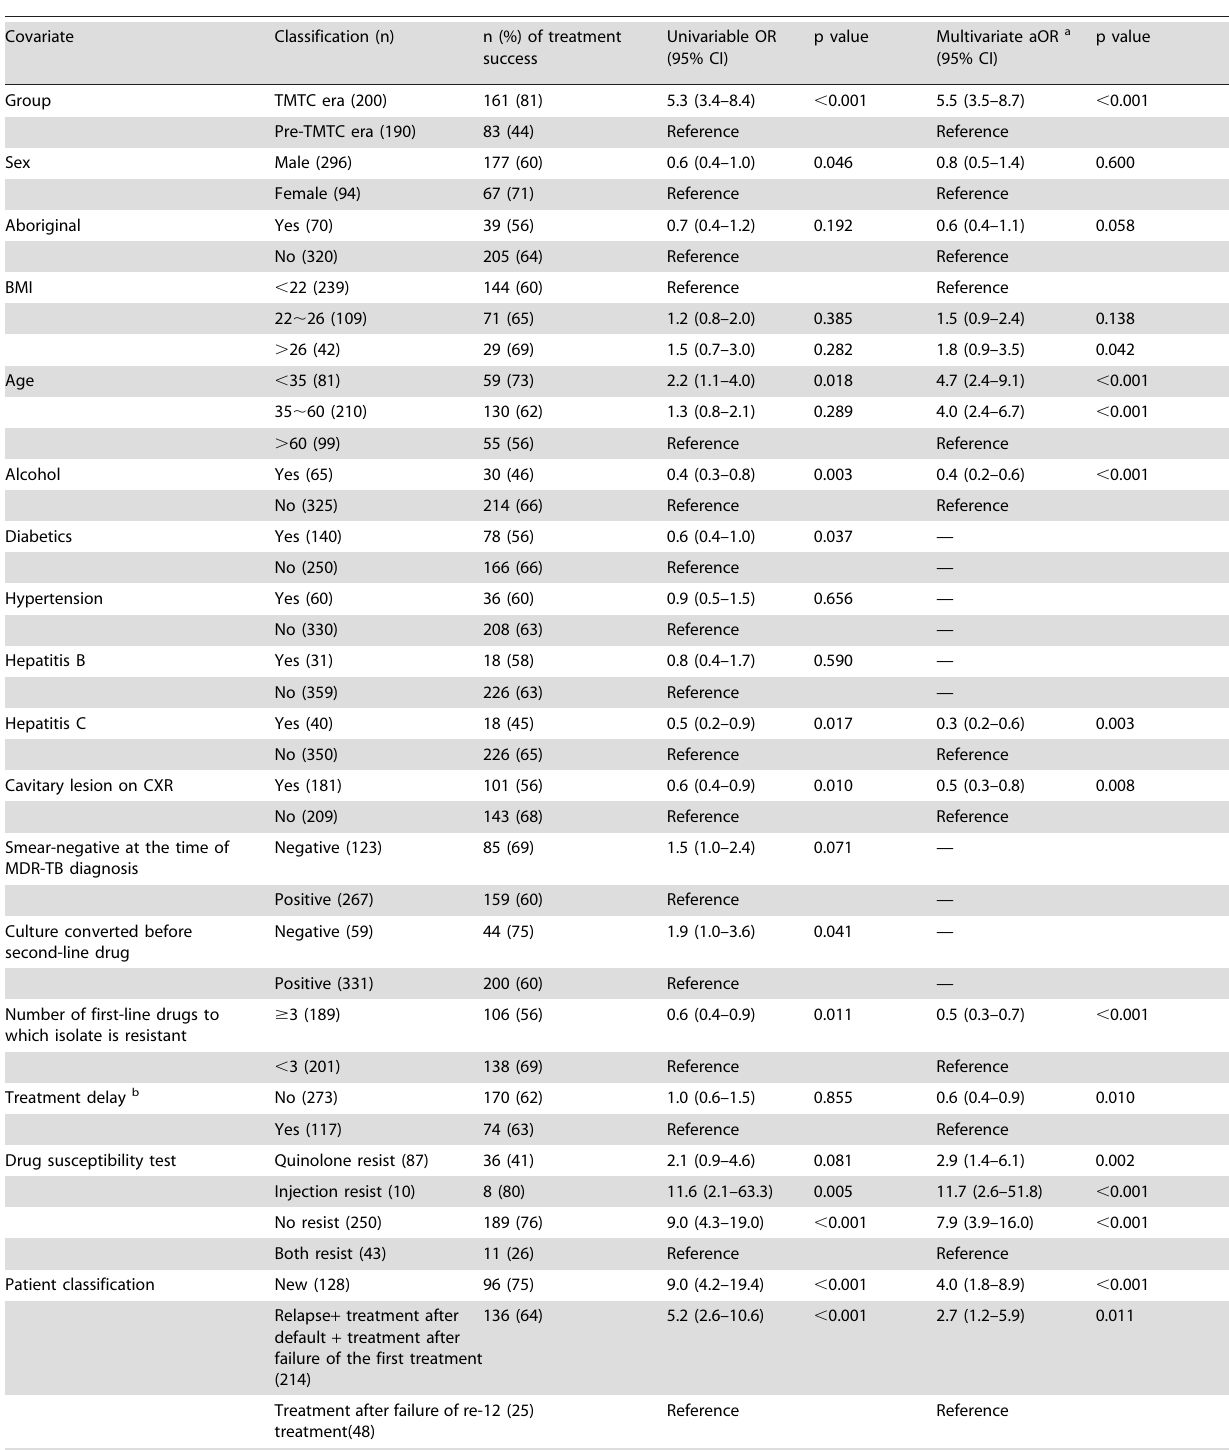
Table 5. Prognostic factors associated with treatment success for 390 patients with results of susceptibility of second-line drug.